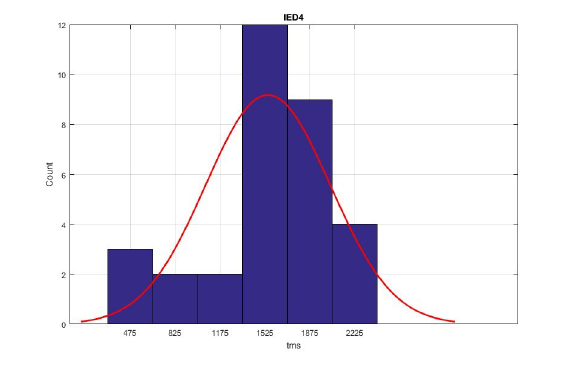
Figure 9: Histogram for the DPST.ECPConn based IED1-IED4 round trip time